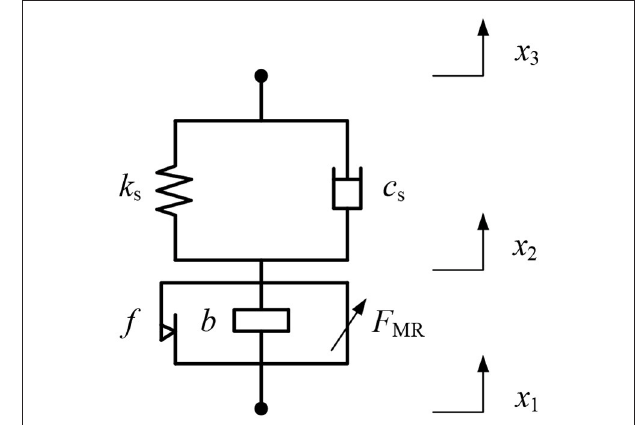
FIGURE 7 | Nonlinear model of the SAI.